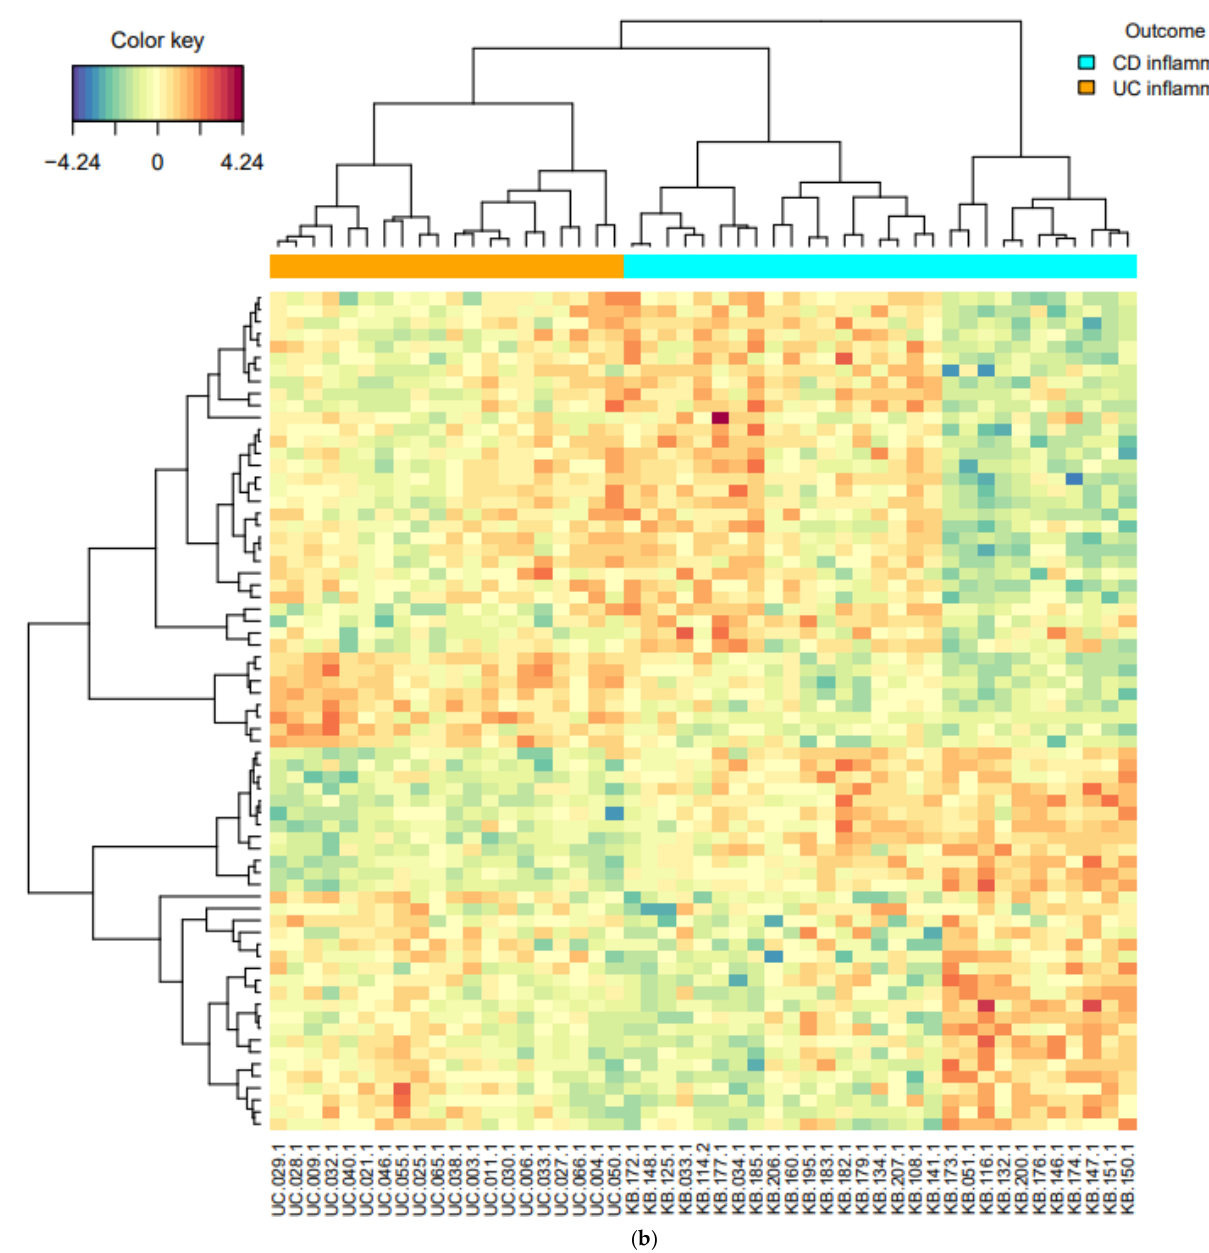
Figure 3. The clustering diagrams of the final sparse partial least-squares discriminant analysis (sPLS-DA) model that classifies inflammatory CD vs. inflammatory UC. ( a ) The PLS projection onto the subspace spanned by the two components. The ellipses for each class represent 95% confidence level of discrimination. ( b ) The heatmap hierarchical clustering of 70 genes (rows) and 49 samples (columns). The bottom 20 and top 30 genes belong to component 2, while the middle 20 genes belong to component 1. All plots were drawn with the Bioconductor R package mixOmics .